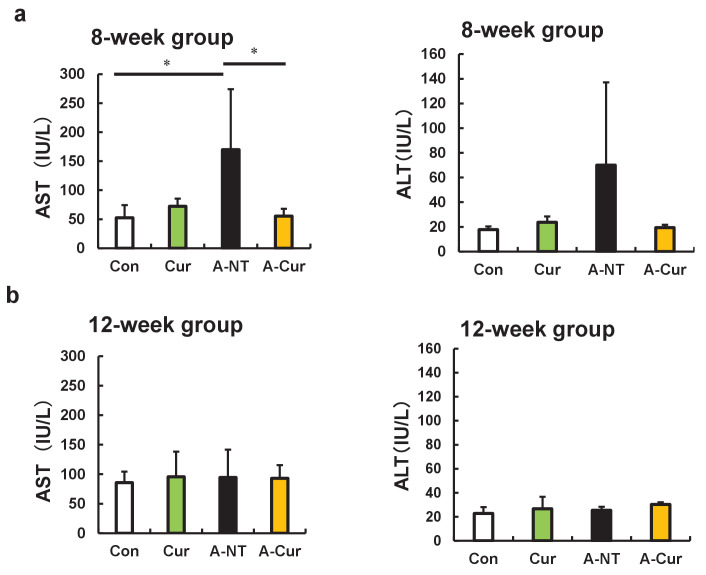
No differences in AST and ALT plasma concentrations after curcumin intake.AST and ALT plasma levels were detected to evaluate hepatocyte injury. (a) AST and ALT concentrations in the 8-week group. (b) AST and ALT plasma concentrations in the 12-week group. Data are mean ± SD. N = 3–5. The Tukey–Kramer method was used for multiple comparisons; *p < 0.05.